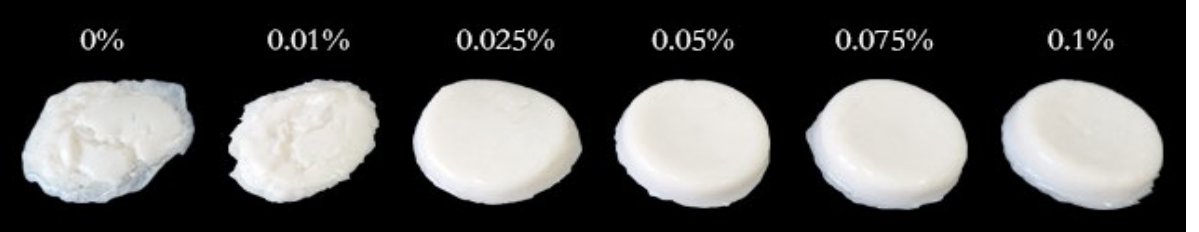
Figure 2. Images of soy yogurt with different LAG contents.